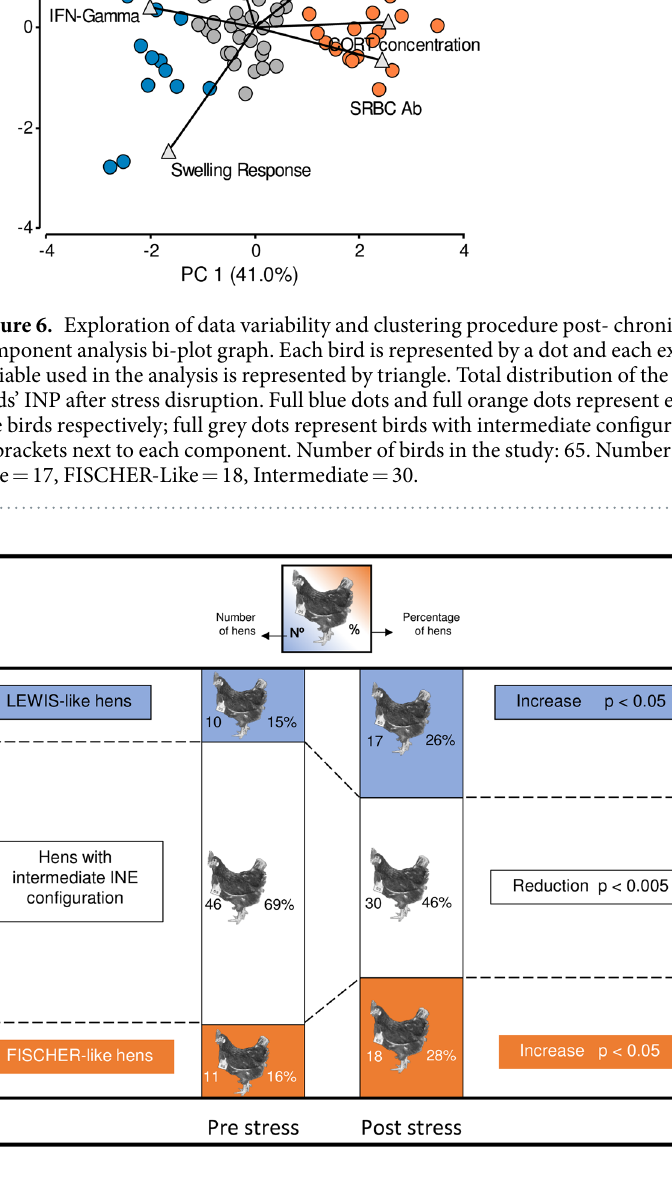
Figure 7. Proportion analysis of stress induced effects. The studied population is schematized previous and post chronic social stress impairment, as cumulative bars. In each bar the different INE configurations are represented in sections with blue (LEWIS-like), white (intermediate) or orange (FISCHER-like) stuffing. Information regarding absolute number and percentage of birds is also given. The final statistical and biological effect of the stress impairment is shown together with p-values. In every case, a p-value < 0.05 was considered to represent significant differences. Total number of animals previous stress = 67, total number of animals post stress =